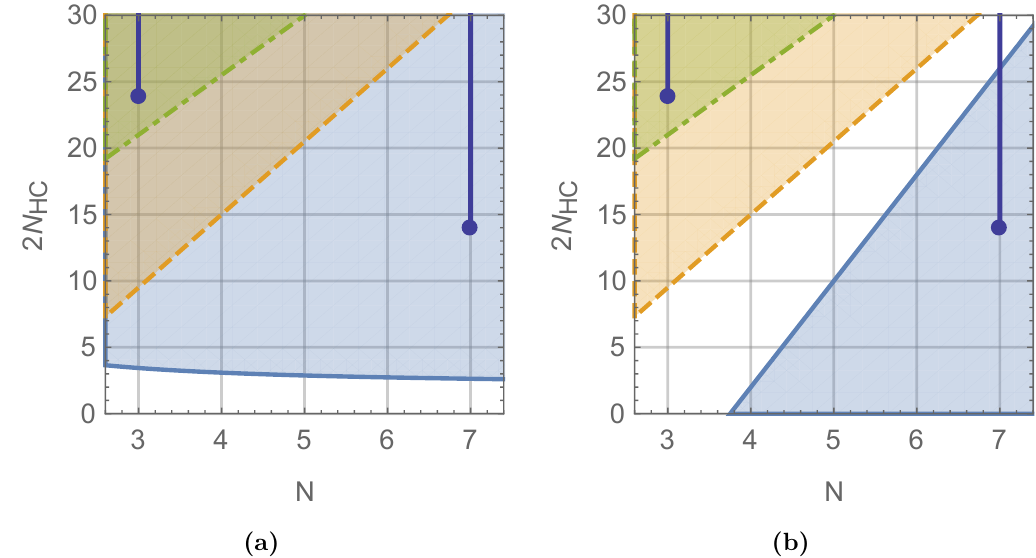
Figure 6. The allowed region for N and N HC for (a) ( R ψ , R χ ) = ( F , A 2 ) , and (b) ( R ψ , R χ ) = ( A 2 , F ) when the hypercolor group is Sp (2 N HC ) . The shaded blue regions are ruled out by b HC < 0 , while the orange (dashed boundary) and green (dot-dashed boundary) regions are ruled out by b 0 < 0 and b N +3 < 0 , respectively. For SU ( N + 3) with N = 3 or 7 , the fermion ξ may instead be in the pseudoreal representation, and the allowed limits are indicated by the values of 2 N HC less than the dark blue